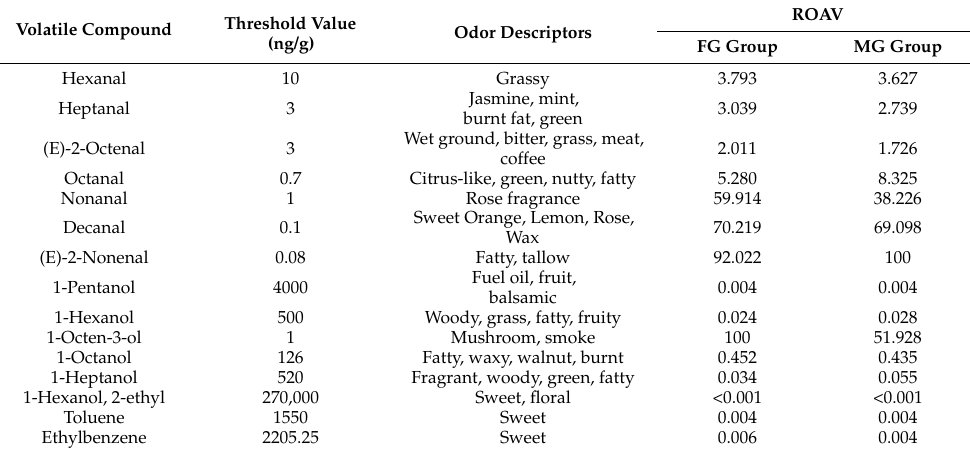
Table 8. Relative odor activity value (ROAV) of the volatile flavor compounds of LT muscle of goats in two